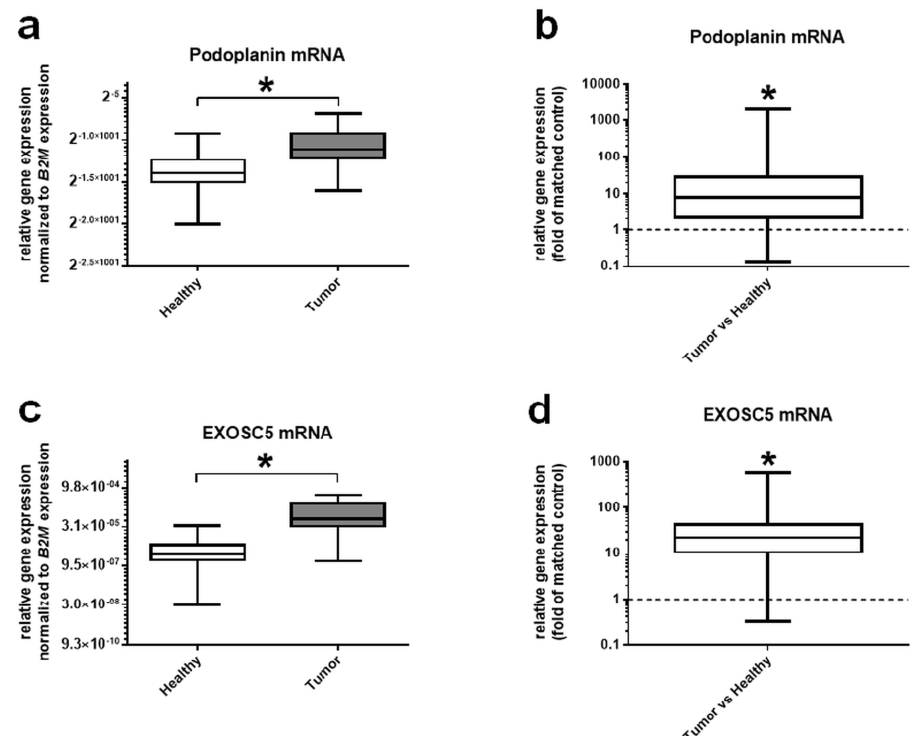
Figure 3. Expression levels of the colorectal cancer marker genes podoplanin and EXOSC5 in healthy and tumor tissue samples. ( a ) Relative gene expression of podoplanin compared to the housekeeping gene B2M. Podoplanin is shown to be significantly more highly expressed in tumor cells. ( b ) Differential relative expression of podoplanin compared to matched controls. ( c ) Relative gene expression of EXOSC5 compared to the housekeeping gene B2M. Additionally, EXOSC5 exhibits a significantly increased expression in tumor cells. ( d ) Differential relative expression of EXOSC5 compared to matched controls. Significant differences are depicted with asterisks (* for p < 0.05).